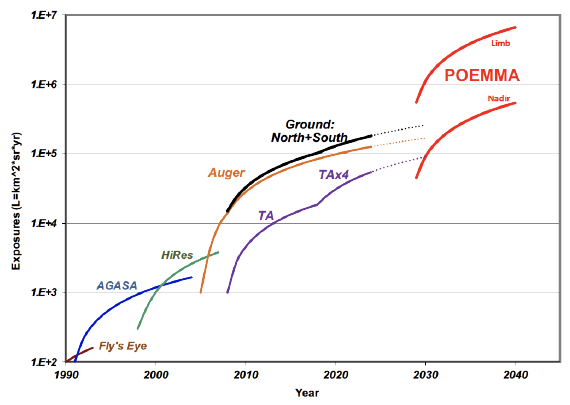
Figure 1. POEMMA’s expected exposure growth as compared to past and current ground-based UHECR